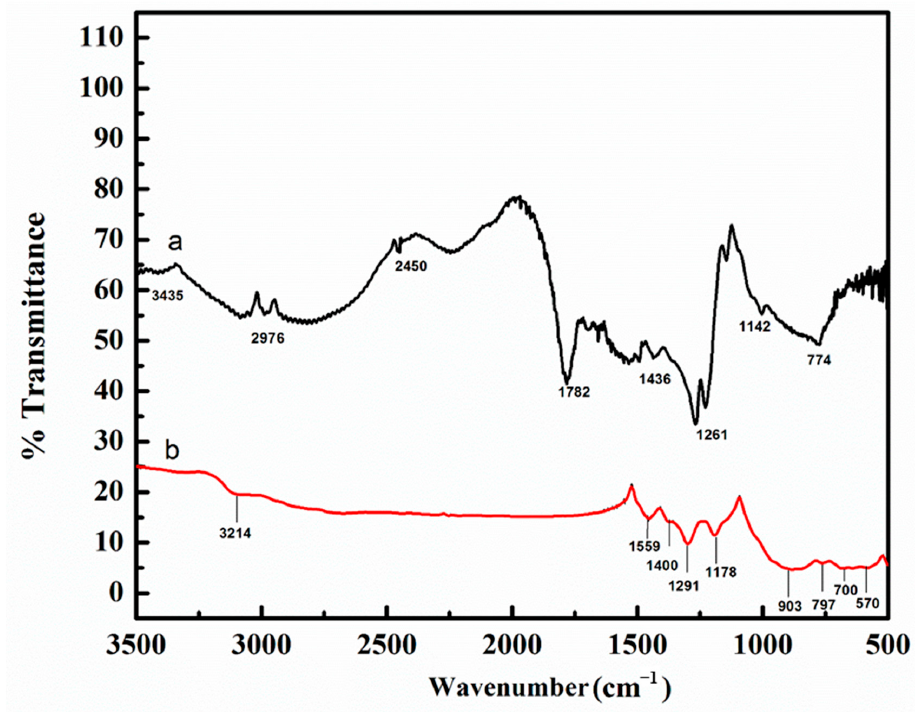
Figure 4. FTIR spectra of ( a ) chitosan film and ( b ) patch - 5.